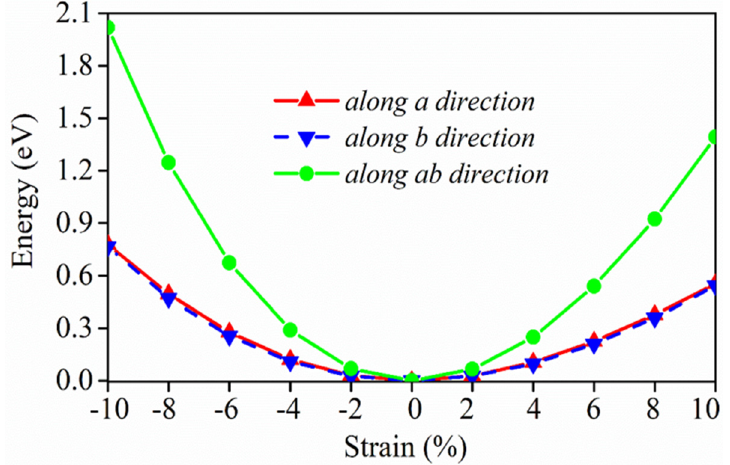
Figure 4. The energy variation relationship when the uniaxial or biaxial strain is −